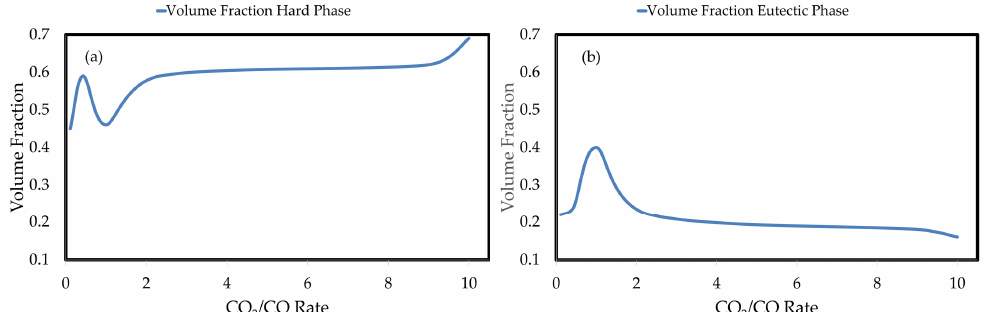
Figure 4. ( a ) Volumetric fraction of hard phase and ( b ) volumetric fraction of eutectic phase, vs. CO 2 /CO.